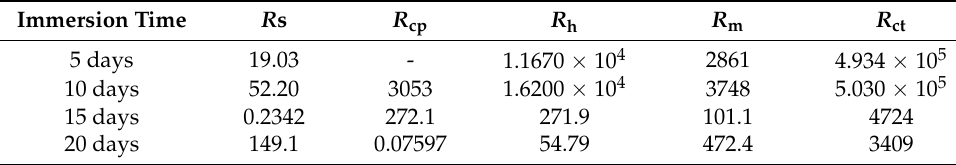
Table 8. EIS data of MAO/APS samples after immersion in SBF for various durations.